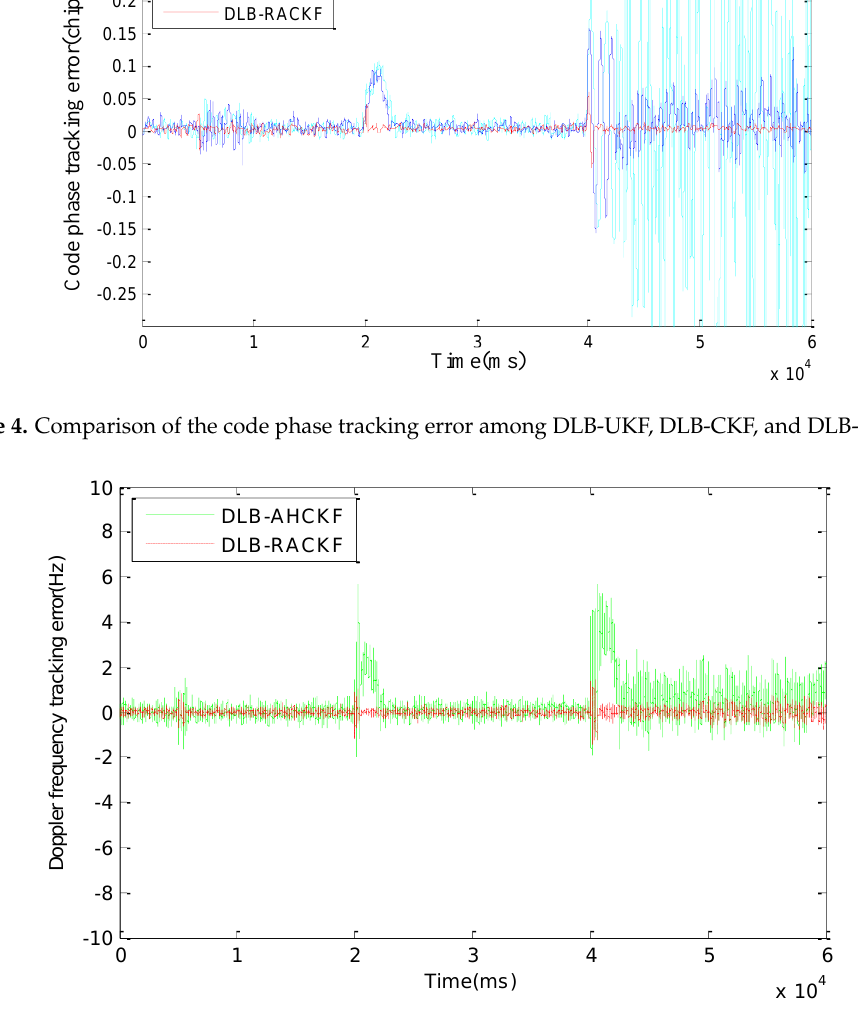
Figure 5. Comparison of code phase tracking error among DLB-AHCKF and DLB-RACKF.